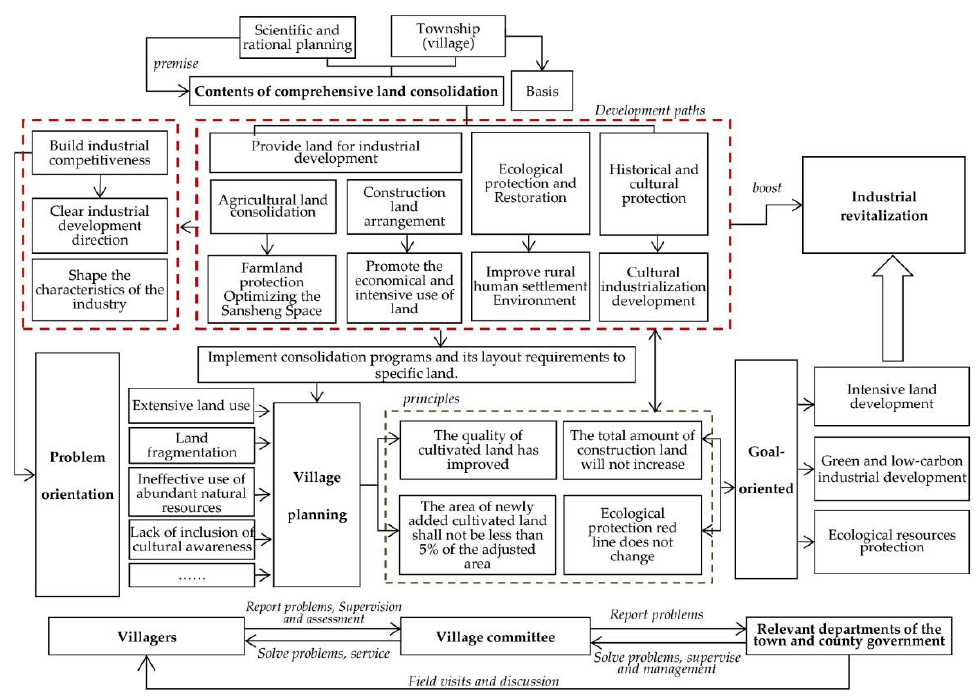
Figure 5. Logical relationships between comprehensive land consolidation and industrial revitalization.